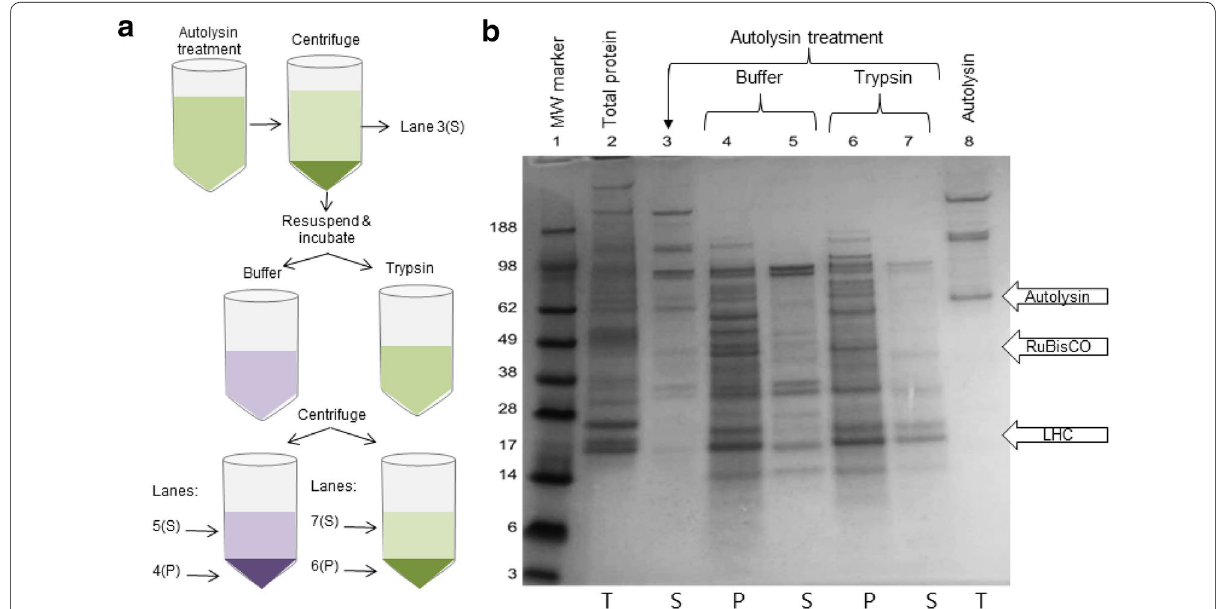
Fig. 7 a Diagram showing sample collection process for gel electrophoresis analysis and b MW protein profile. MW marker (lane 1); Total protein‑10X concentration‑ (lane 2); Supernatant after autolysin treatment‑5X concentration (lane 3); Pellet‑10X concentration‑(lane 4) and supernatant‑22.5X concentration (lane 5) after incubation in buffer at 35°C for 24 h, no trypsin; Pellet‑10X concentration (lane 6) and supernatants‑22.5X concentration‑(lane 7) after autolysin treatment and resuspension in buffer plus trypsin; and Autolysin‑17X concentration (lane